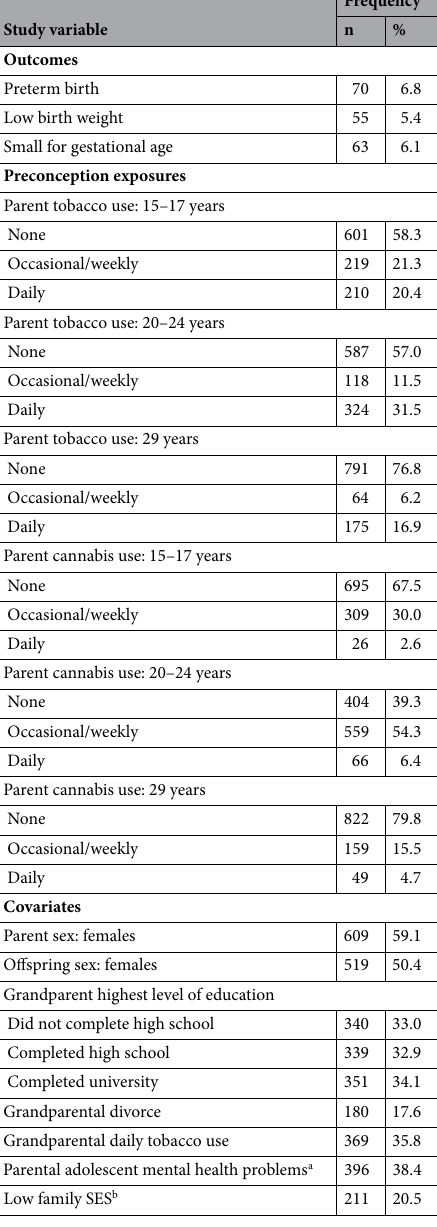
Table 1. Characteristics of 1030 children born to 665 parents in the Victorian Intergenerational Health Cohort Study (data imputed and N estimated from proportions). a Depression/anxiety assessed prospectively through the revised Clinical Interview Schedule. b Home postcode at study entry within the lowest 20% of the Index of Relative Socio-economic